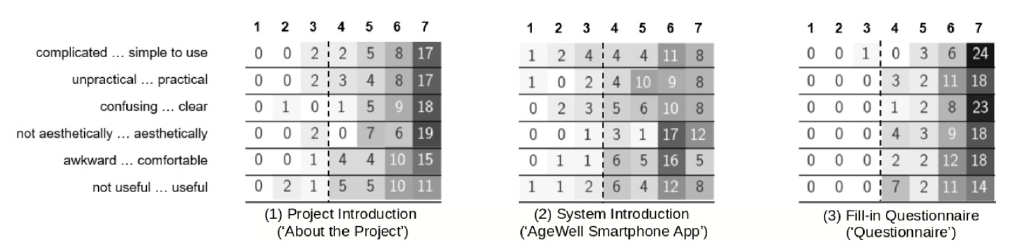
Figure 7. Attractiveness of the three functions of the robot ( n = 34).